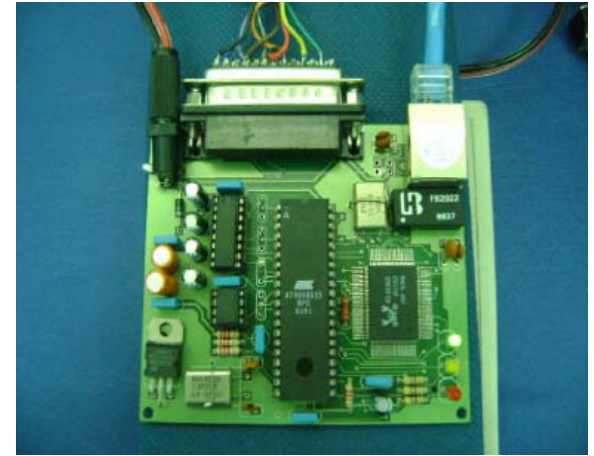
Figure 1. Web Micro Server – MWS